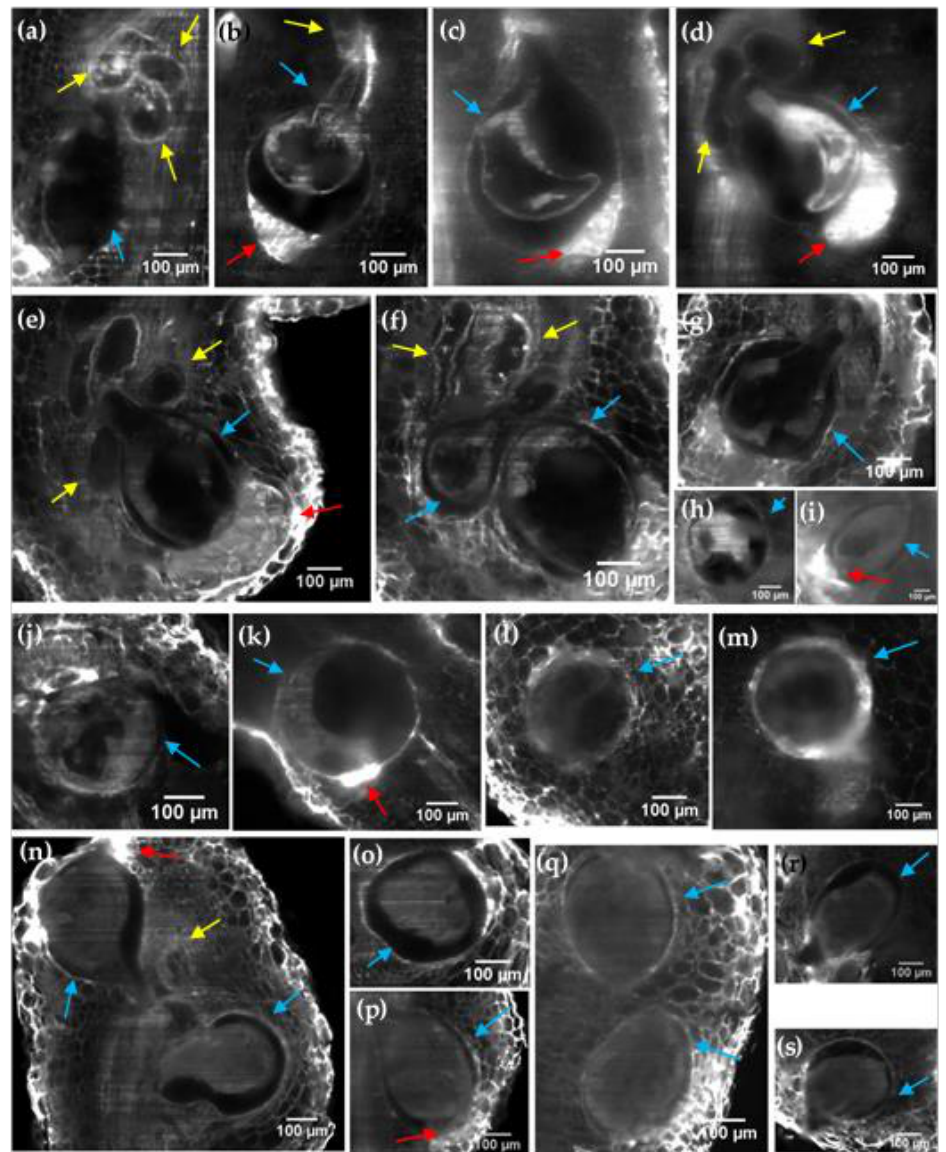
Figure 4. LSFM imaging of tomato ( a – m ) and eggplant ( n – s ) galled roots 6 weeks after M. incognita inoculation. ( a ) Tomato gall roots 1-propanol–ECi treated. ( b – d ) Tomato gall roots methanol–ECi treated. ( e – i ) Tomato gall roots 1-propanol–BABB treated. ( j ) Tomato gall roots ethanol–BABB treated. ( k – m ) Tomato gall roots methanol–BABB treated. ( n , o ) Eggplant gall roots ethanol–BABB treated. ( p , q ) Eggplant gall roots 1-propanol–ECi treated. ( r , s ) Eggplant gall roots 1-propanol–BABB treated. Giant cells (yellow arrows), nematode females (blue arrows) and egg masses (red arrows) are indicated. Scale bar: 100 µ